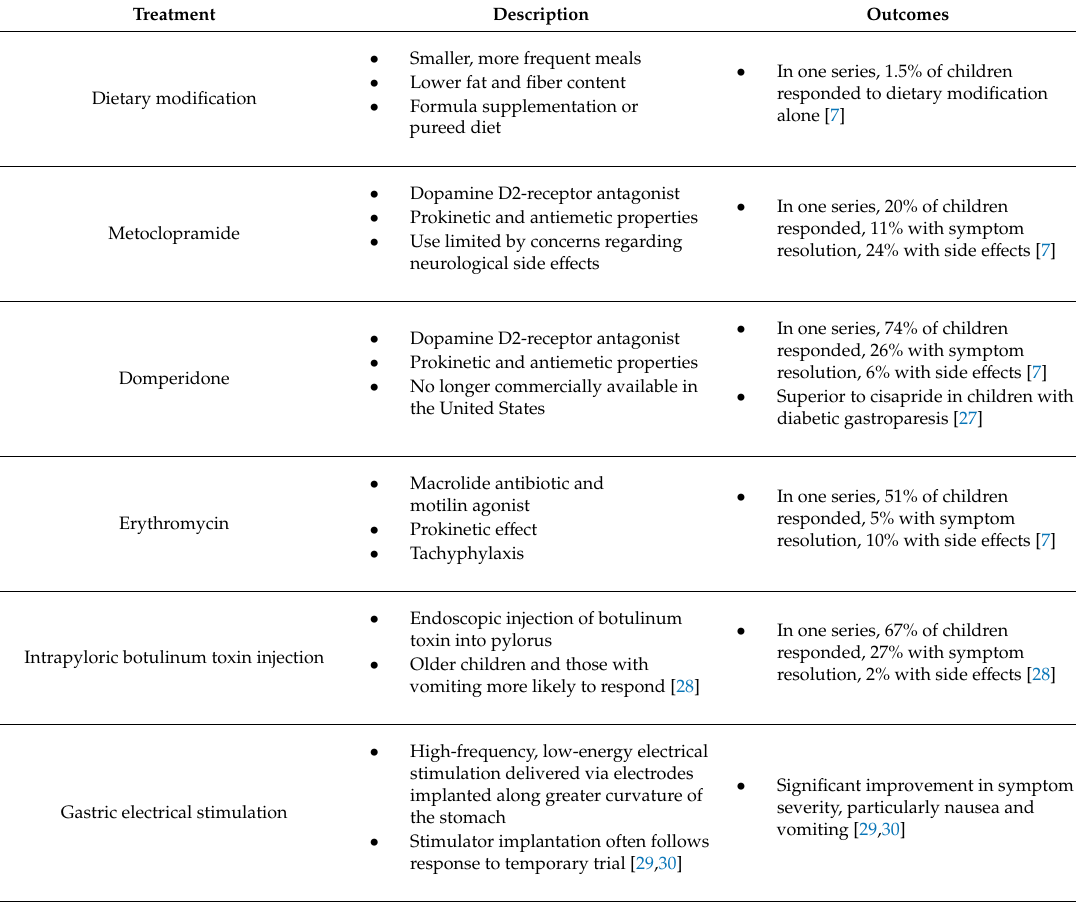
Table 2. Summary of the treatments used for children with